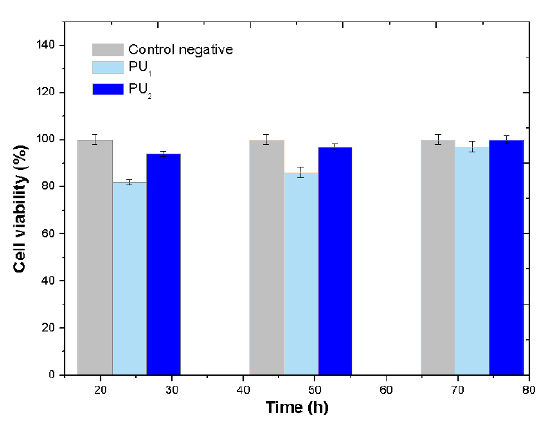
Figure 6. Cell viability measured by MTT